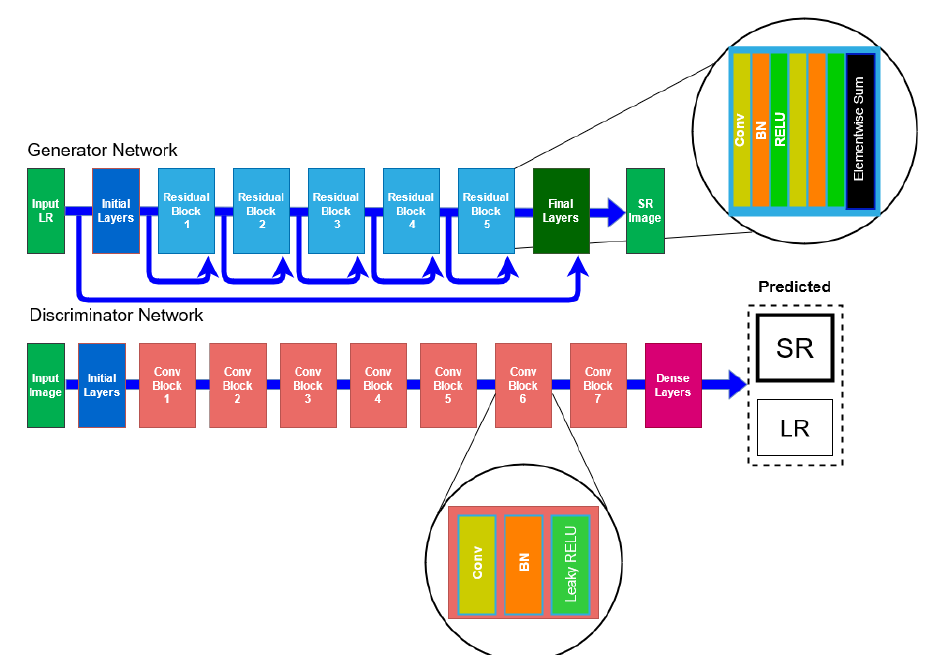
Figure 7. Generator and discriminator architecture of SRGAN inspired by [7].